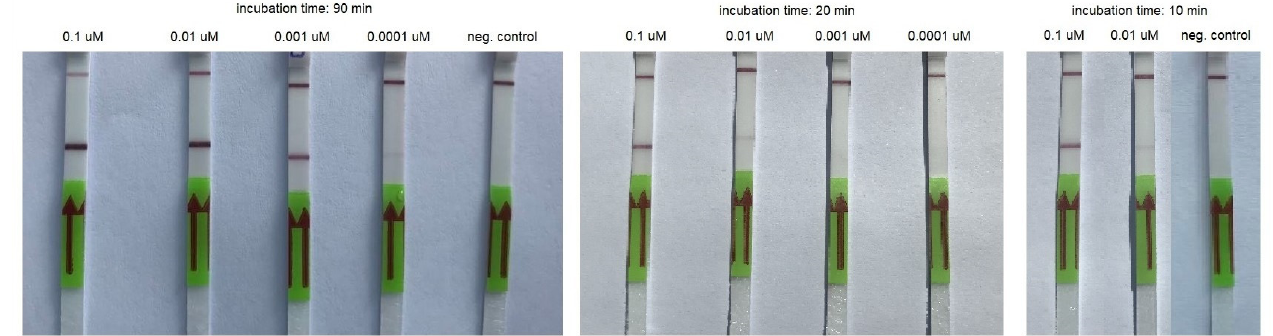
Figure 3. An example of RT-HDA combined with LFA performed using serial dilutions of the synthetic template and various incubation times. Table 4. Limit of detection (LOD) for RT-HDA combined with LFA using control RNA as a template. Concentration of the Synthetic Template (Copies/Reaction)